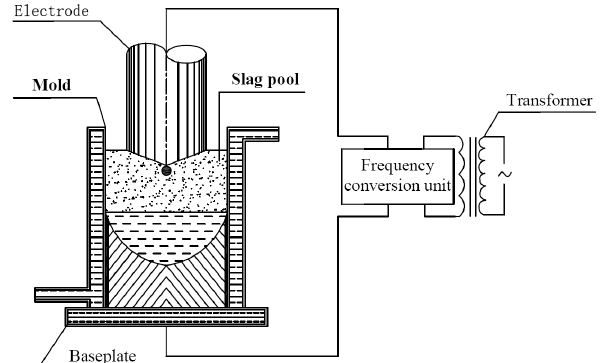
Figure 1. Low-frequency (DC) electroslag remelting furnace.